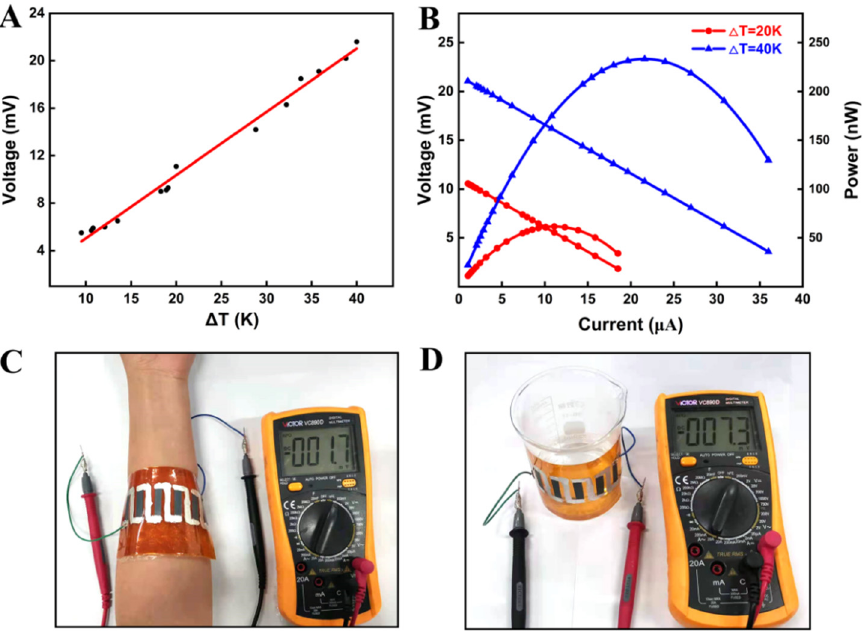
Figure 6. ( A ) PI30 F-TEG open voltage changes with ∆ T. ( B ) The relationship between the output voltage and current and power at ∆ T = 20 K and 40 K. ( C ) The image of 1.7 mV voltage generated by ∆ T between the arm and the environment. ( D ) The image of 7.3 mV voltage generated by ∆ T between the upper (cold) and lower (hot) surfaces of the beaker.